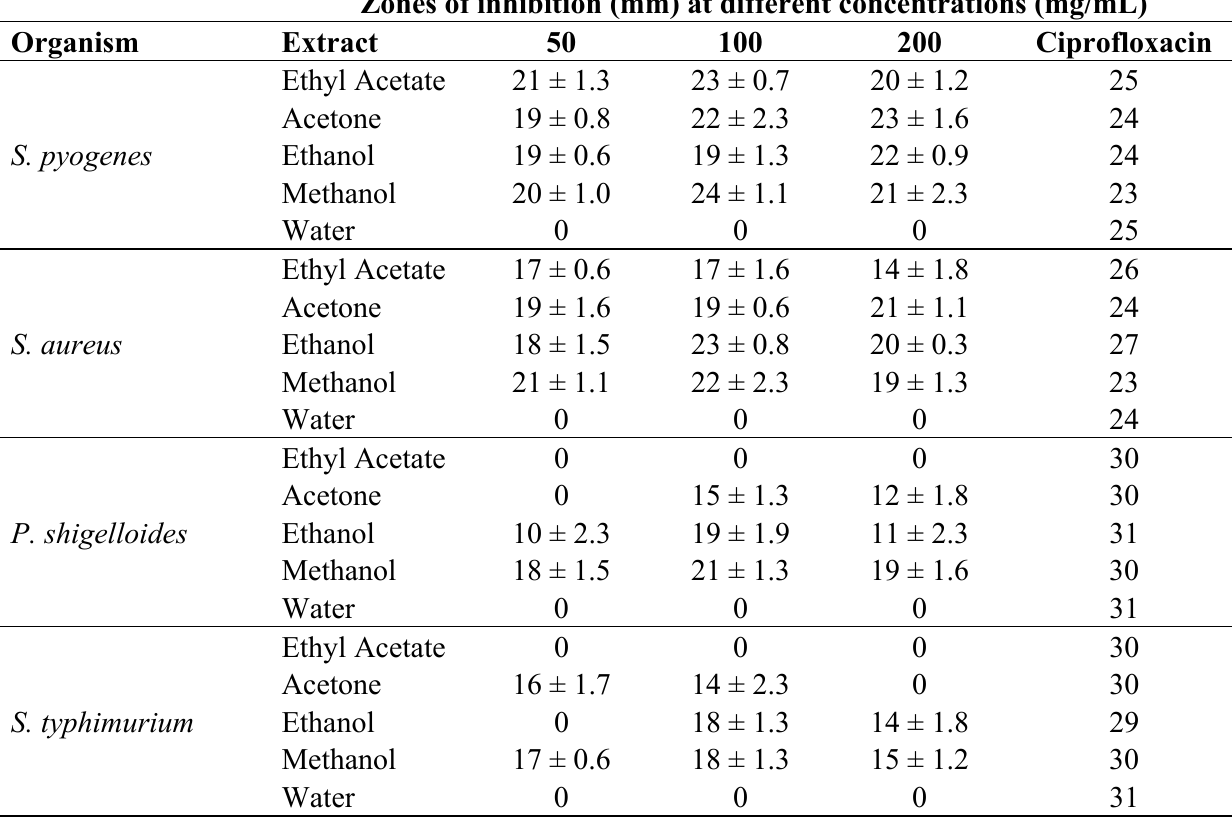
Table 1. Zone of inhibition ± SD (mm) of the seed extracts of G. kola and ciprofloxacin (1.25) (mg/mL) against